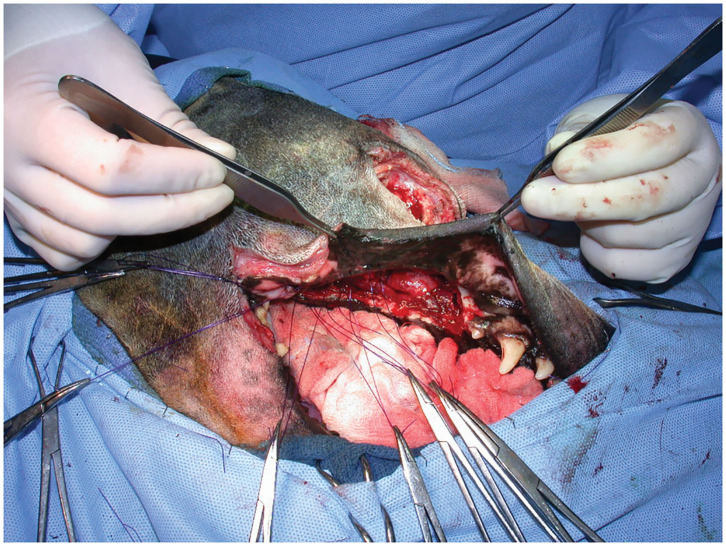
Intraoperative photograph following arterial preligation and caudal maxillectomy via a combined approach. Note the lack of hemorrhage on the surgical drape.